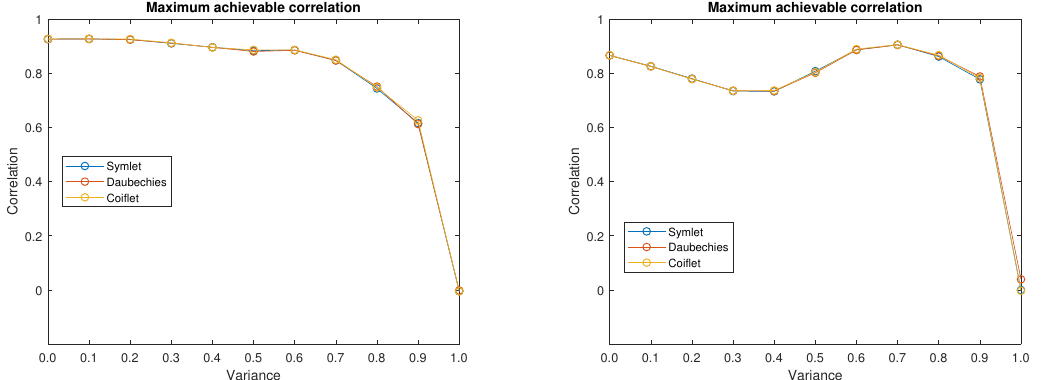
Figure 10. Maximum achievable correlation levels with use of three mother wavelet families for two different input